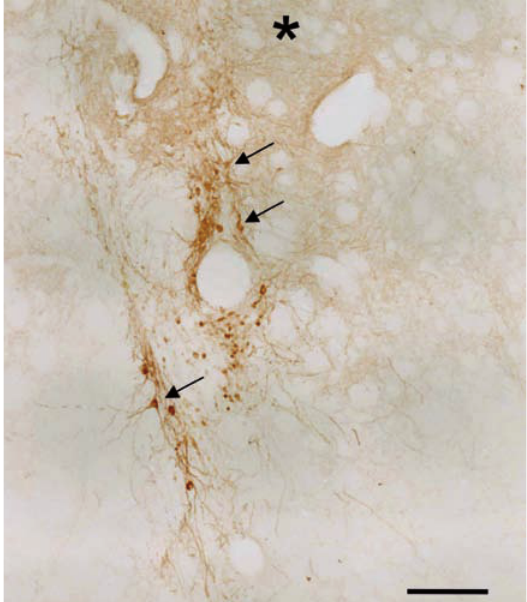
Photomicrograph of rat embryonic dopaminergic precur- sor cells transplanted in a rat model of Parkinson’s disease and immunohisto- chemically stained for tyrosine hydroxy- lase (TH). TH-im- munoreactive grafted cells (arrows) survive in the host brain and extend TH-immunore- active axons into the denervated striatum (asterisk). Scale bar: 200 m